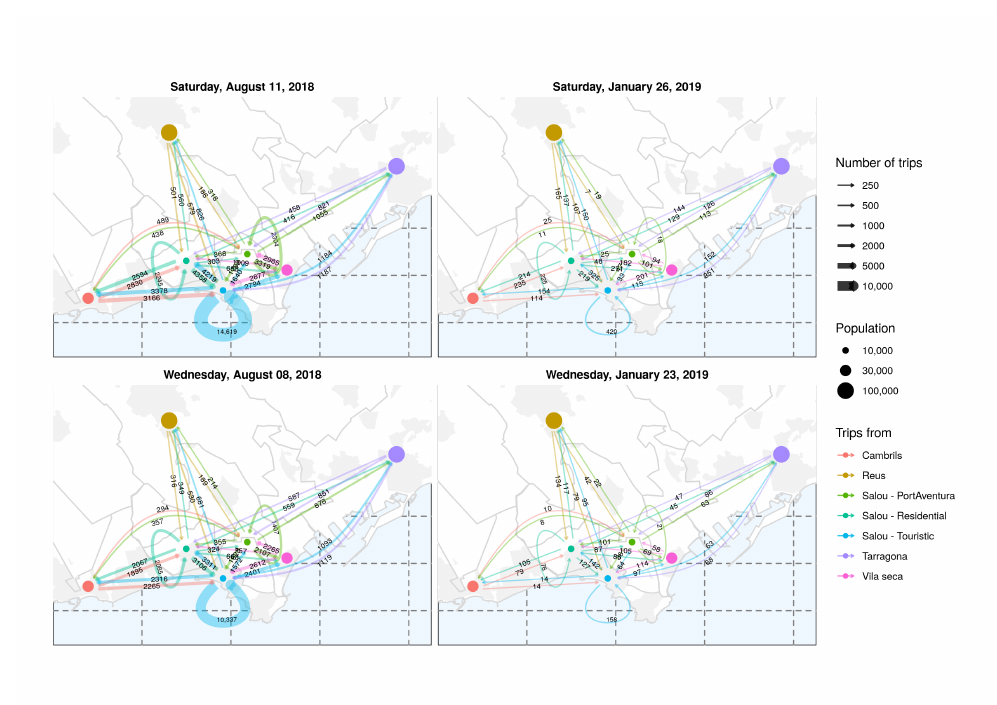
Figure 5. Flow maps of the intra-urban and inter-urban mobility in Salou of the Spanish tourists (from outside the province of Tarragona).